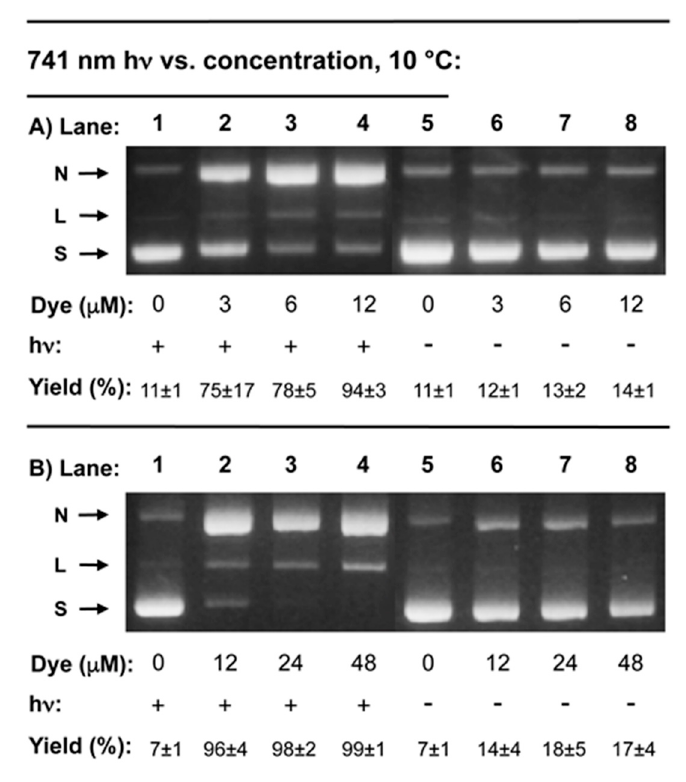
Figure 4. Representative agarose gels showing photocleavage of 38 µM bp pUC19 DNA in the presence of dye 4 concentrations ranging: ( A ) 0–12 µM; and ( B ) 0–48 µM (10 mM sodium phosphate buffer pH 7.0, 10 °C). Reactions were either irradiated with a 741-nm LED lamp (0.3 W/cm 2 ; spectral output 707–759 nm) for 60 min or kept in the dark. Data points are averaged over 2–3 trials. Errors represent standard deviation. Abbreviations: N, nicked; S,